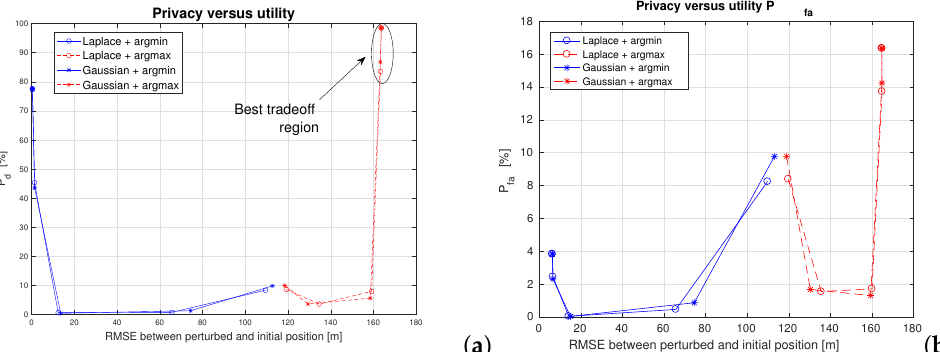
Figure 10. Privacy versus utility tradeoff. Proximity threshold γ = 2. The plots illustrate the behavior of the argmin vs argmax metrics against RMSE. ( a ) P d as utility; ( b ) P fa as